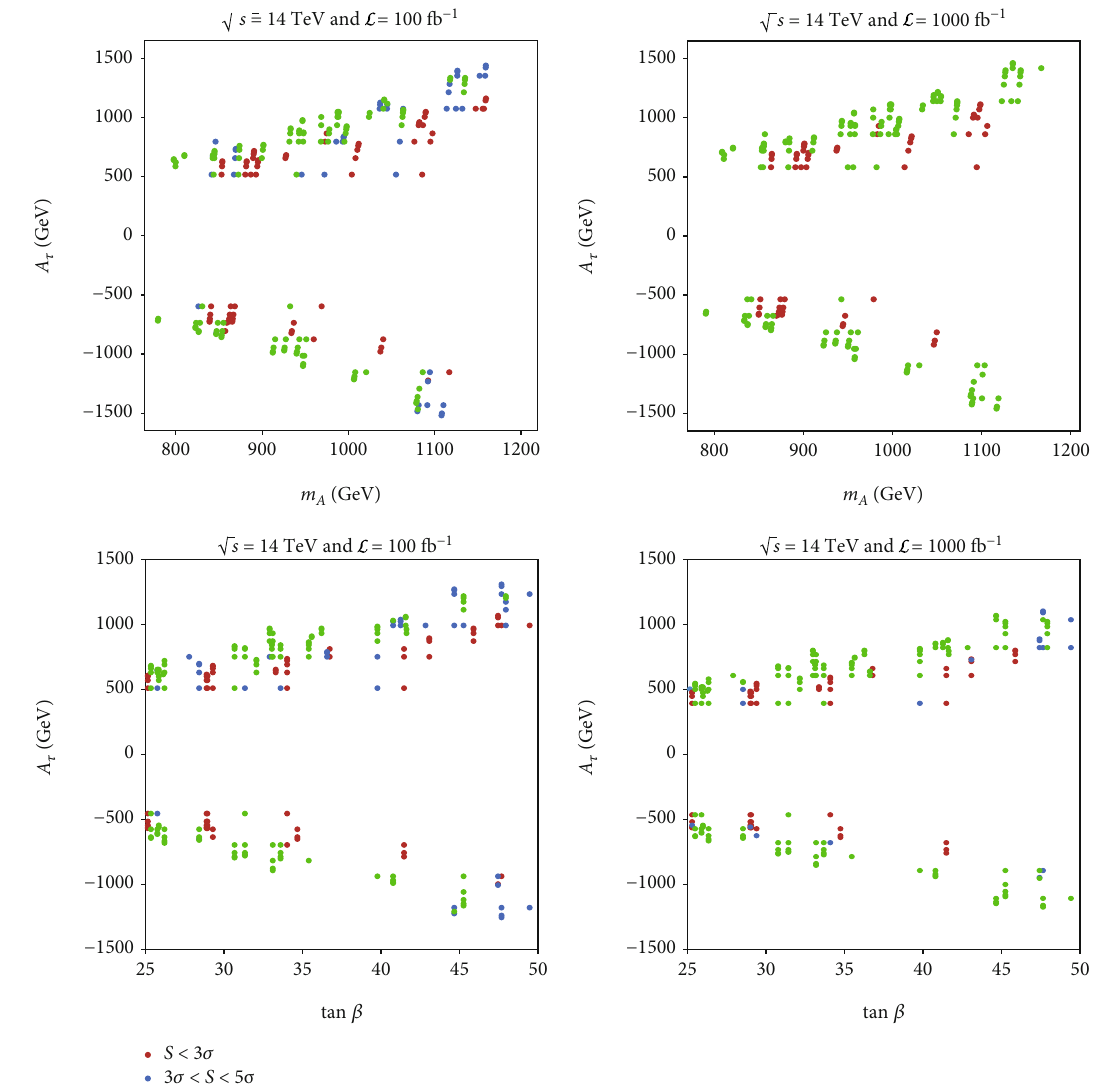
Figure 7: Signal signi fi cance in the ½ m , A τ (cid:2) plane (a, b) and ½ tan β , A τ (cid:2) plane (bottom plots), within Scenario II for a center-of-mass energy of ffiffi p A = 14 TeV and total integrated luminosities of 100fb -1 (a, c) and 1000fb -1 (b, d). Benchmarks with signi fi cances below the evidence level s ( S < 3 σ ), between the evidence level and the discovery level ( 3 σ < S < 5 σ ), and above the discovery level ( S > 5 σ ) are shown in red, blue, and green,